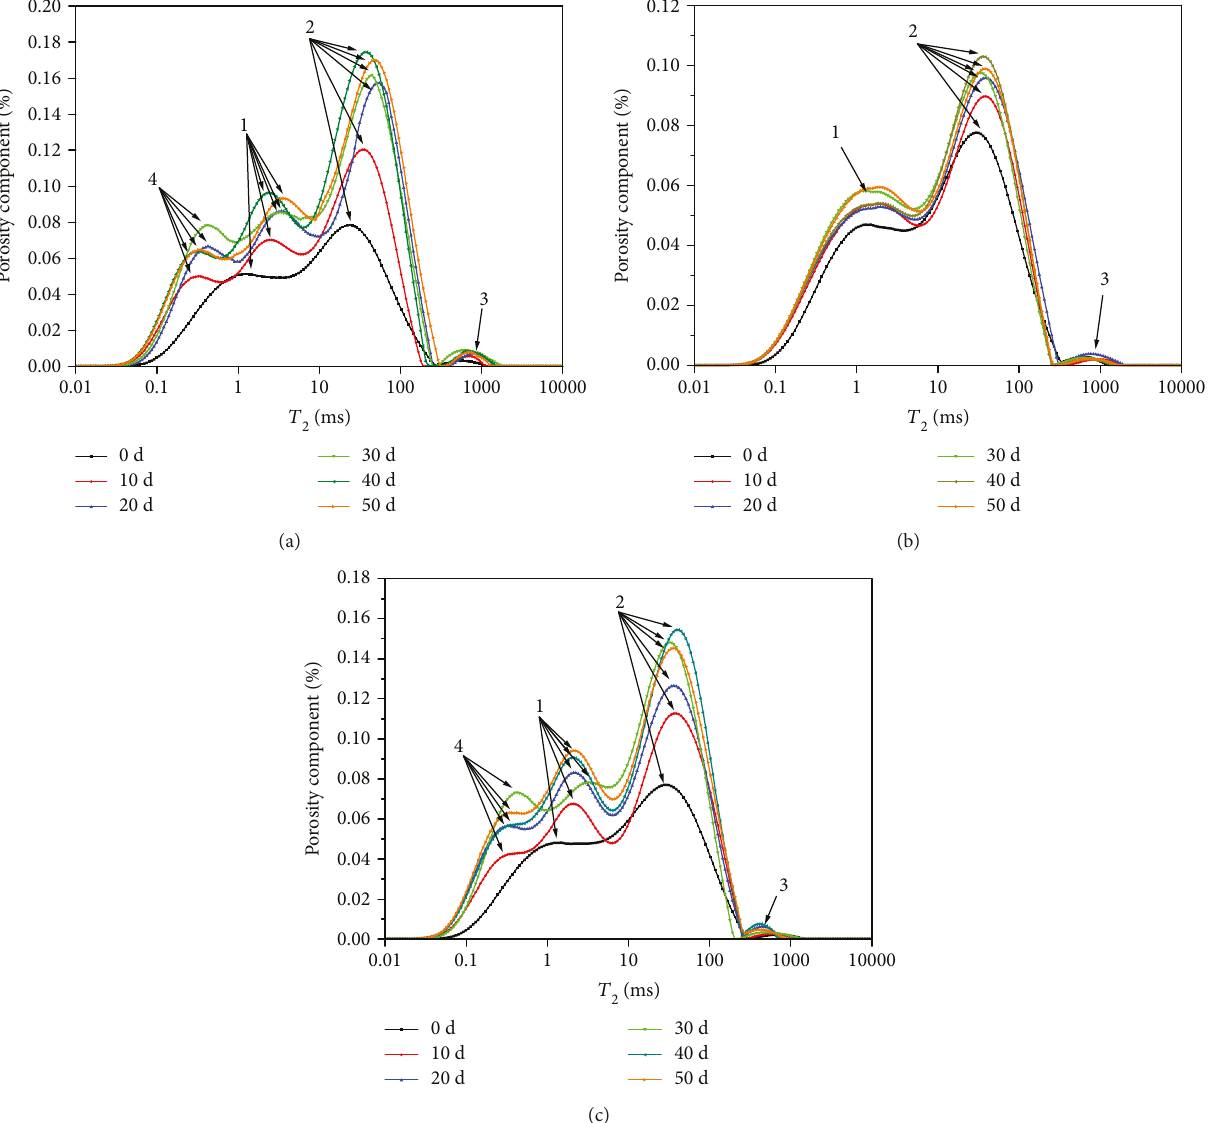
SO solution; (b) distilled water; and (c) 2 4